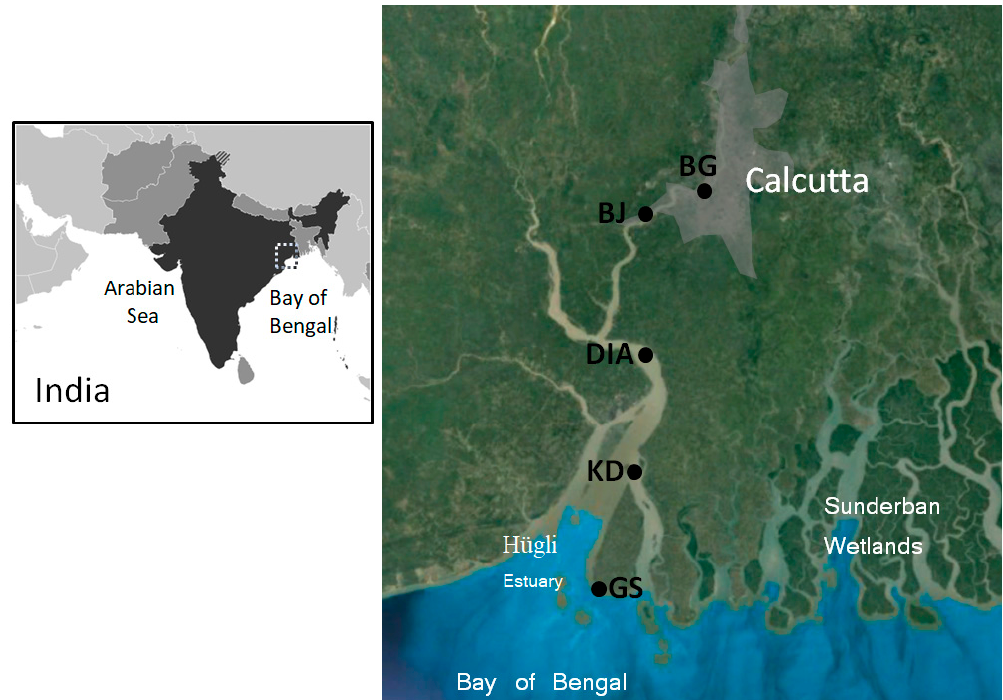
Figure 1. Map showing the location of the sampling stations from the Ganges River towards the Estuary (NE India), and the situation of the Sundarbans Wetlands. Latitude and longitude data are included in Table 1.